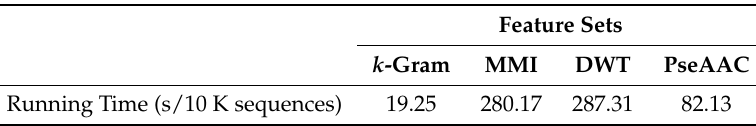
Table 5. Running time of each feature extraction